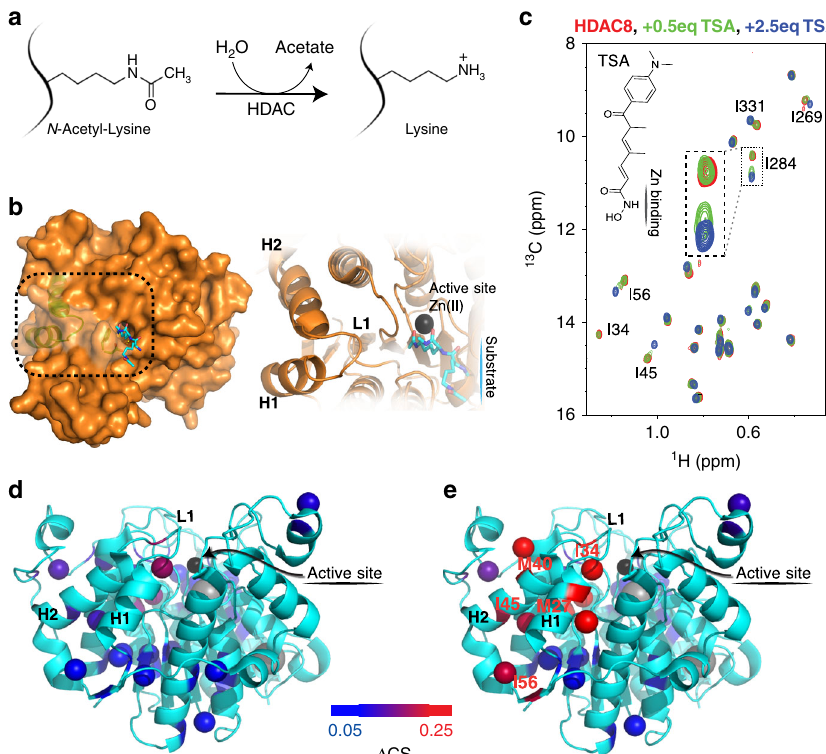
Fig. 1 Coupling between helix1-loop1-helix2 and the active site. a The deacetylase reaction catalysed by HDACs. b Surface structure of HDAC8 (PDB: 2v5w) with substrate bound (left) and structural elements discussed below highlighted (right). c Methyl-TROSY NMR spectra of isoleucine δ 1-methyl groups in HDAC8 (30 μ M). Overlay of free-form (red), with sub-stoichiometric (14 μ M; green) and excess (blue) amounts of TSA (75 μ M). Distinct changes are observed for the labelled residues. d , e Structural representation of isoleucine and methionine chemical shift changes, Δ CS, upon ( d ) SAHA and ( e ) TSA binding. Long-range effects, up to 28 Å from the binding site, are observed upon TSA binding. The shift changes are calculated as Δ CS Ile ð Þ ¼ based on the standard deviation of assigned chemical shifts 65 . Isoleucine-34 was coloured red in e . due to peak disappearance upon saturation with